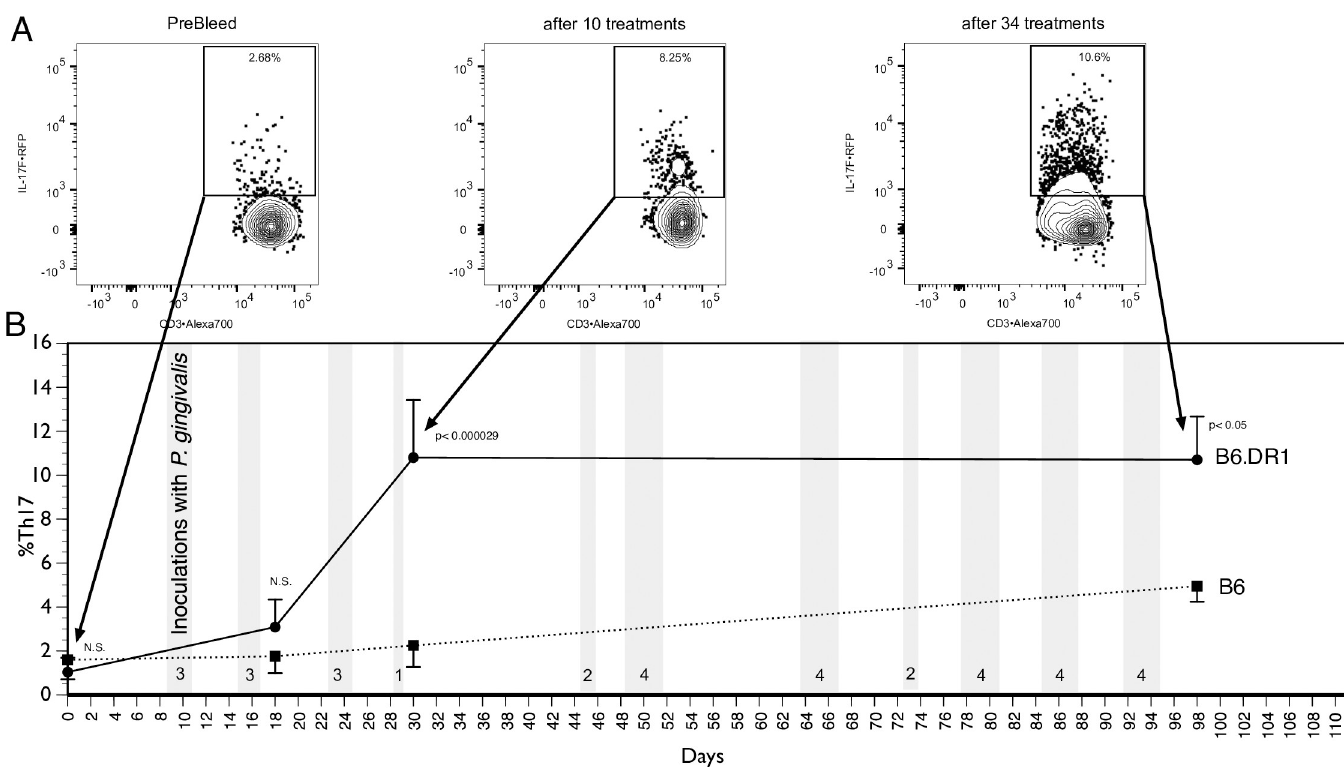
Fig 1. An elevated percentage of CD4 + T cells in peripheral blood that express the Th17 phenotype are found in SE-expressing mice. Representative multicolor flow cytometric scatter plots before (A) and after (B) inoculation of B6.DR1 mice with P . gingivalis . Square gates represent the percentage of DAPI + CD45 + CD3 + CD4 + cells among the PBMCs that are expressing IL-17F. Peripheral blood samples from WT (B6) or B6.DR1 mice were analyzed by flow cytometry (C) before (Day 0) and at three times post oral inoculation (vertical grey bars) with P . gingivalis . Events are gated on DAPI + CD45 + CD3 + CD4 + cells, and results are expressed as the percentage of these cells among PBMCs that are of the Th17 phenotype. Stats: t-test.